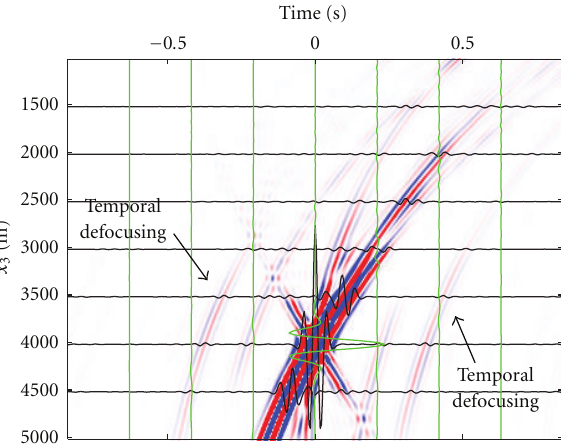
Figure 26: Source spectra to mimic varying source-side conditions (dB scale).